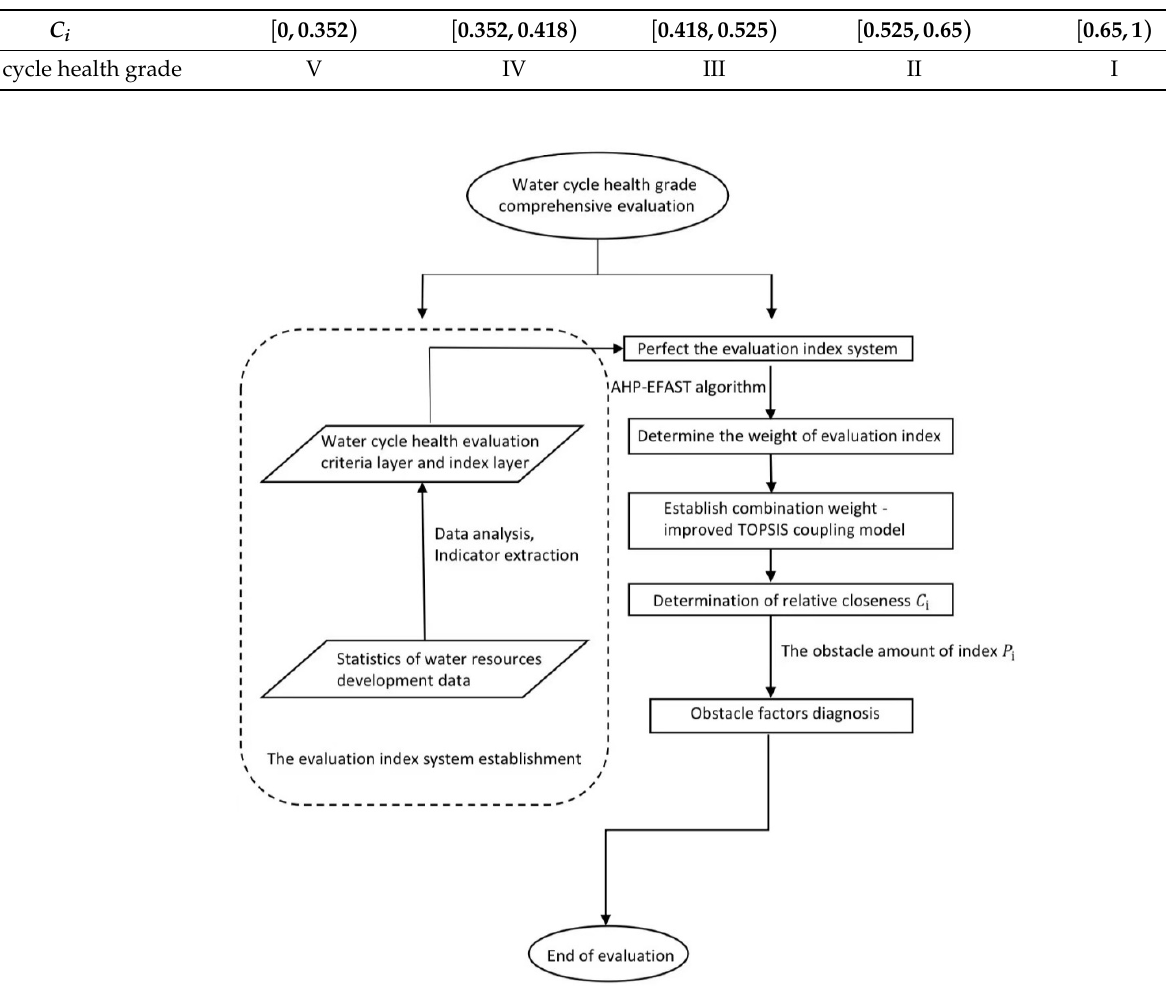
Figure 4. Flow chart of water cycle health assessment.